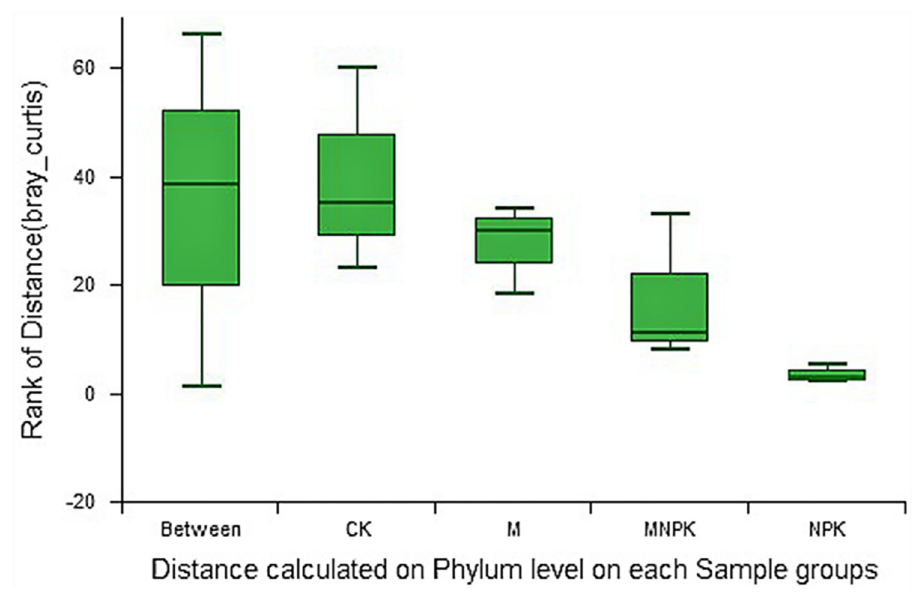
Fig 2. Analysis of similarities under different treatments at the Phylum level. The distance along the x-axis is the rank of distance value within or between groups. “Between” represents the distance value of the difference between the groups; group names represent the difference distance value within each group. The Y-axis represents the Bray-Curtis dissimilarity.